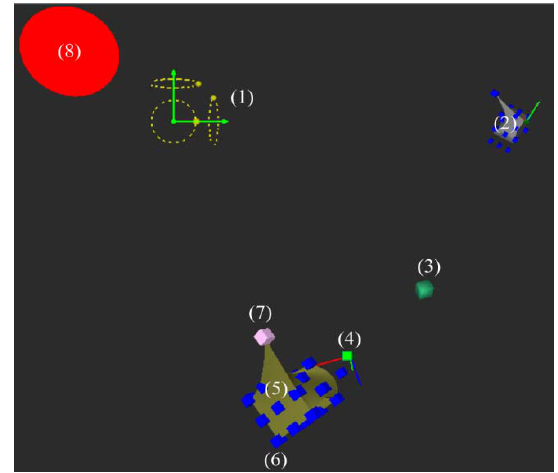
Figure 2. Objects presented in the CVE: (1) widget indicator, (2) target object B , (3) reference point, (4) starting point, (5) manipulator object A , (6) control point, (7) selected control point, and (8) go signal.